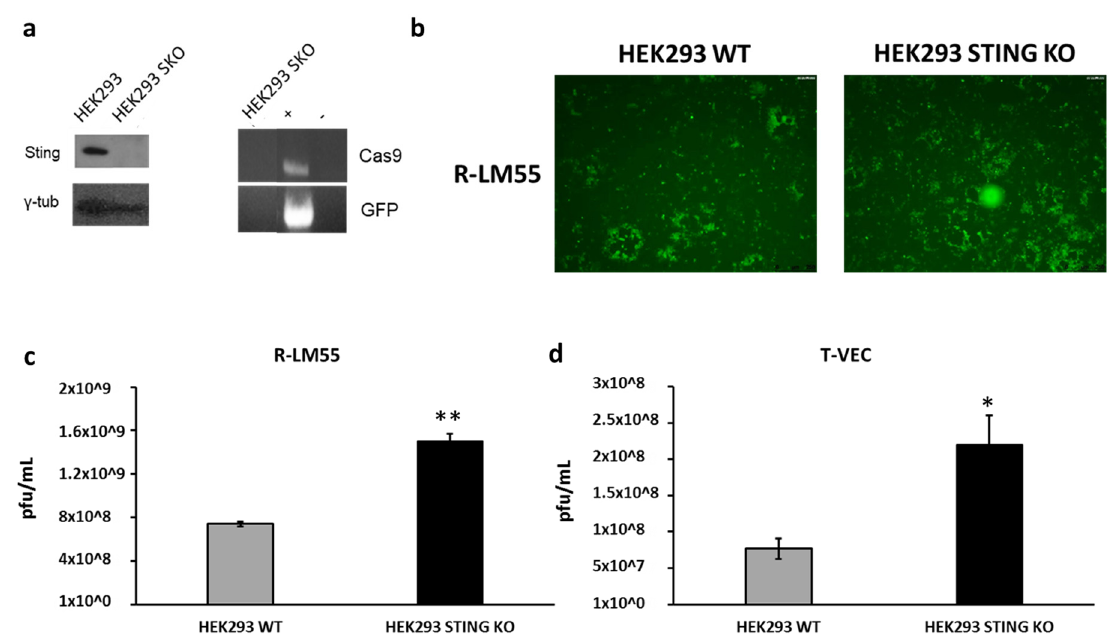
Figure 5. Generation of improved oncolytic virus producing cell line. ( a ) STING gene was knocked out in HEK293 cells as assessed by Western blot analysis; gamma-tubulin was used as standard. PCR screening confirmed the absence of eGFP and Cas9 residues in genomic DNA; Cas9/eGFP-encoding vector was used as positive control (C+) and genomic DNA from parental HEK293 cell was used as negative control (C − ). ( b ) R-LM55 viral spread enhancement was demonstrated in HEK293 STING KO cell line compared to HEK293 WT cell line. ( c , d ) Enhancement viral yield was demonstrated on HEK293 STING KO vs. parental infected with R-LM55 and T-VEC viruses. The statistical significance was calculated by Student’s t-test comparing HEK293 STING KO and HEK 293 WT and resulted p < 0.005 ** and p < 0.05 *, respectively, for R-LM55 and T-VEC